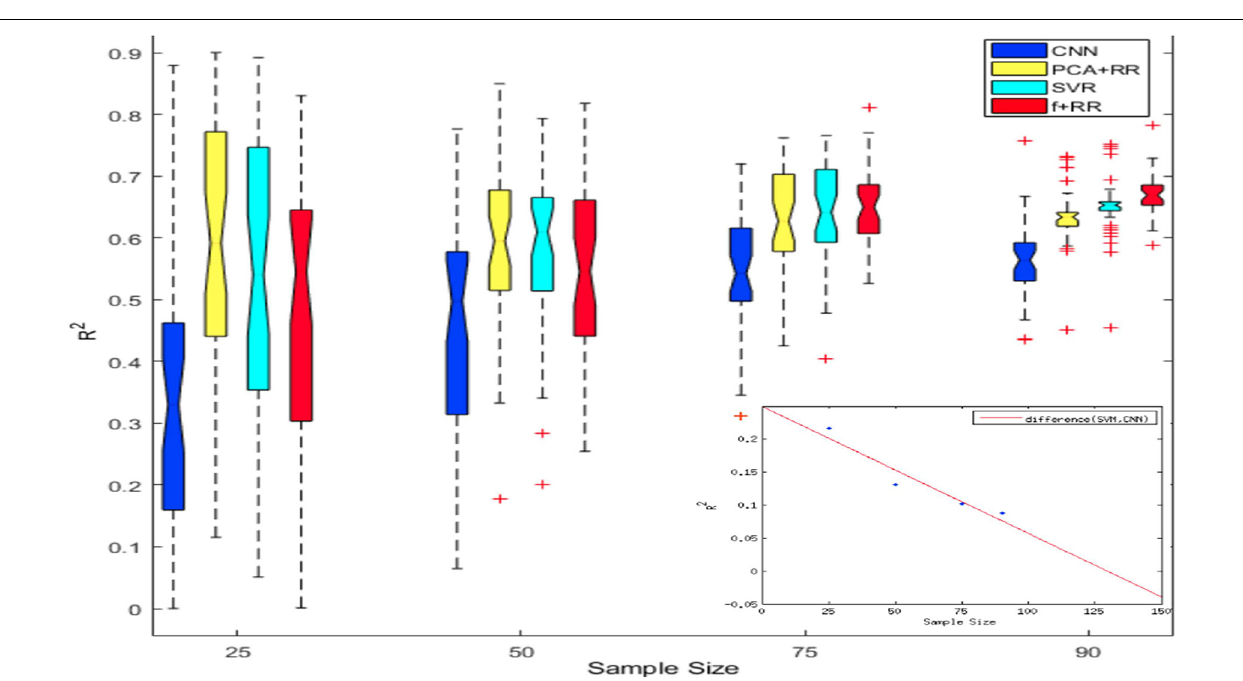
FIGURE 6 | Notched box plot showing the prediction performance ( R 2 ) on 40 runs for each sample size and method. At the smaller sample sizes the performance levels of CNN or Hybrid models are either poorer or statistically similar to that of SVR and PCA-RR models (overlapping notches of the boxplot). However, at sample size of 90 the Hybrid model outperformed all other models. The inset plots the CNN performance gap (difference in R 2 values) with increasing sample size in comparison to the SVR model; the best fitting function (red line) is extrapolated up to a sample size of